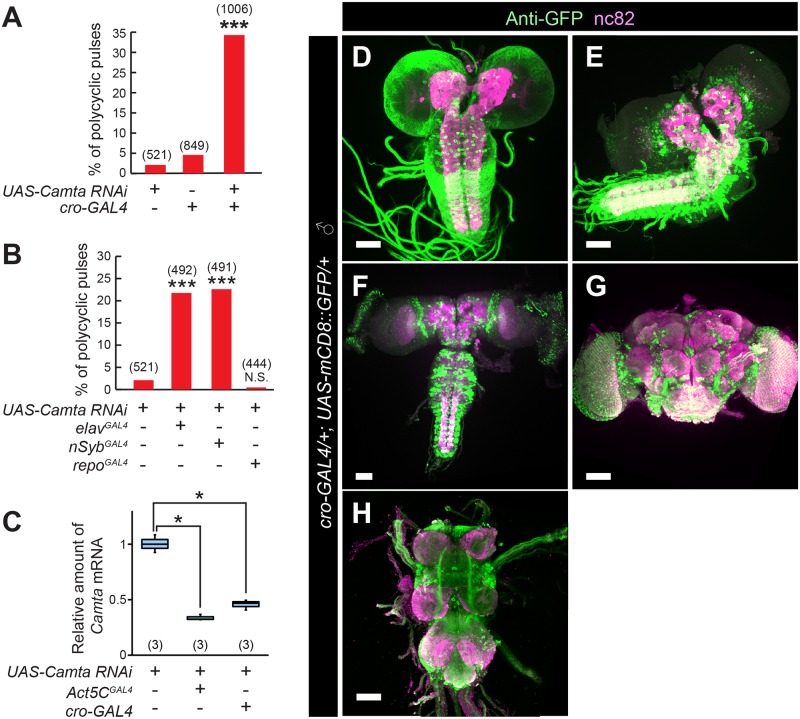
cro knockdown in cro-GAL4-positive neurons induces polycyclic pulses.(A and B) Knockdown of Camta via cro-GAL4 (A), elavGAL4 and nSybGAL4 but not repo-GAL4 (B) induces polycyclic song. The proportion of polycyclic pulses was compared among the genotypes indicated. The tested flies carry transgenes marked with + at the bottom. (B) fruGAL4 but not dsxGAL4 is effective in inducing the song phenotype when used as a GAL4 driver. The proportion of polycyclic pulses (%) is shown in the bar chart and the number of pulses analyzed is indicated in parentheses. Statistical significance was evaluated by the Fisher’s exact probability test. ***: P< 0.001; NS: not significant. (C) qPCR reveals a reduction of Camta transcripts by RNAi-mediated knockdown as driven by Act5C-GAL4 or cro-GAL4. The flies examined carried the transgenes indicated by the plus mark below the box plot graph. The number of replicates is shown in parentheses. The box plot shows the median and 10th, 25th, 75th, and 90th percentiles. The statistical significance of differences was evaluated by Kruskal-Wallis analysis followed by Steel’s nonparametric multiple comparisons: *: P<0.05. (D-H) cro-GAL4 expression is widespread in the central nervous system at the third instar larva (D), wandering stage larva (E), pupa (F), and adult stages (brain: G; VNC: H). Scale bars: 50 μm (D-H).